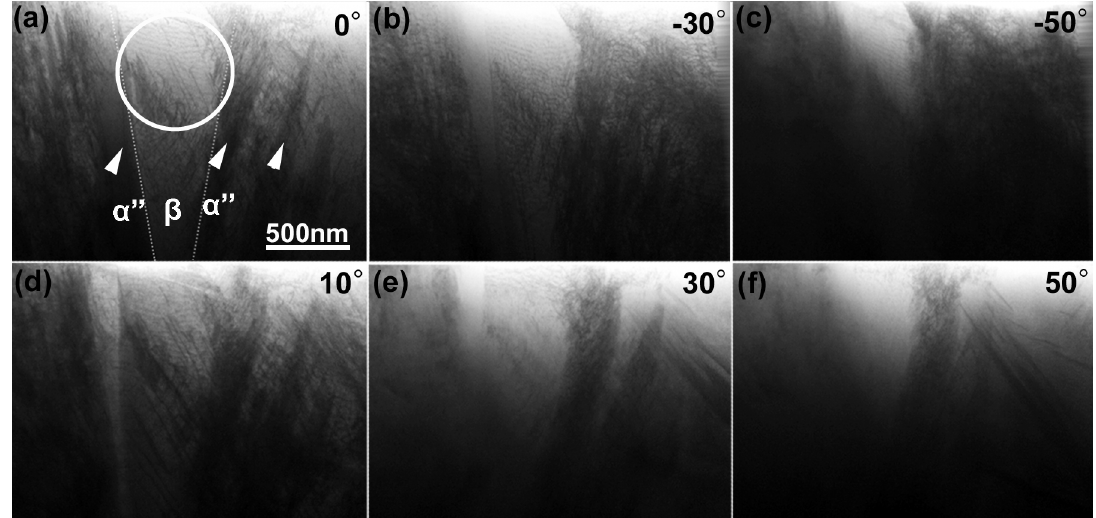
Figure 3. Snapshots of bright-field scanning transmission electron microscopy (BF-STEM) images of the as-quenched Ti–35mass%Nb alloy acquired during a tilt-series observation. SAED patterns were observed from a circular area indicated in ( a ). Arrowheads indicate acicular α '' martensite plates. Dotted lines indicate α ''/ β grain boundaries. Tilt angles for each image is as follows: ( a ) 0°, ( b ) − 30°, ( c ) − 50°, ( d ) 10°, ( e ) 30°, ( f ) 50°. Figure 4 shows a magnified BF-STEM image and a corresponding SAED pattern of the Ti–35mass%Nb alloy observed at a stage tilt of 0°. The image contrast shown here is reversed in order to clearly show fine dislocation arrangement. The beam incidence is close to the [223 are dense dislocations in the β phase region. The rectangular area indicated by dashed lines was selected for subsequent 3D reconstruction.